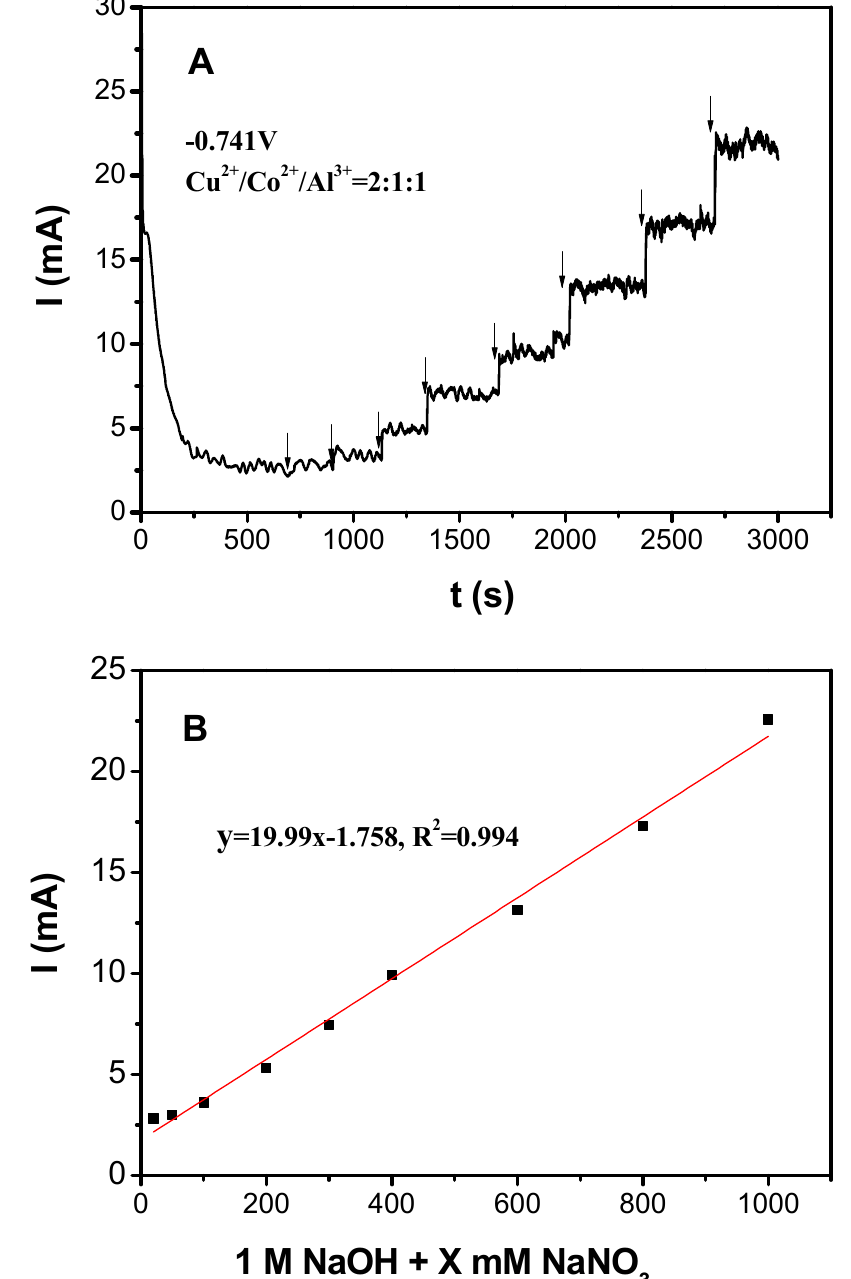
Figure 6. ( A ) Amperometric response of the Cu 2 CoAl–HTLC at an applied potential of − 0.741 V (vs. Hg / HgO) to the successive addition of nitrate; ( B ) linear relationship between nitrate concentration and the corresponding current.